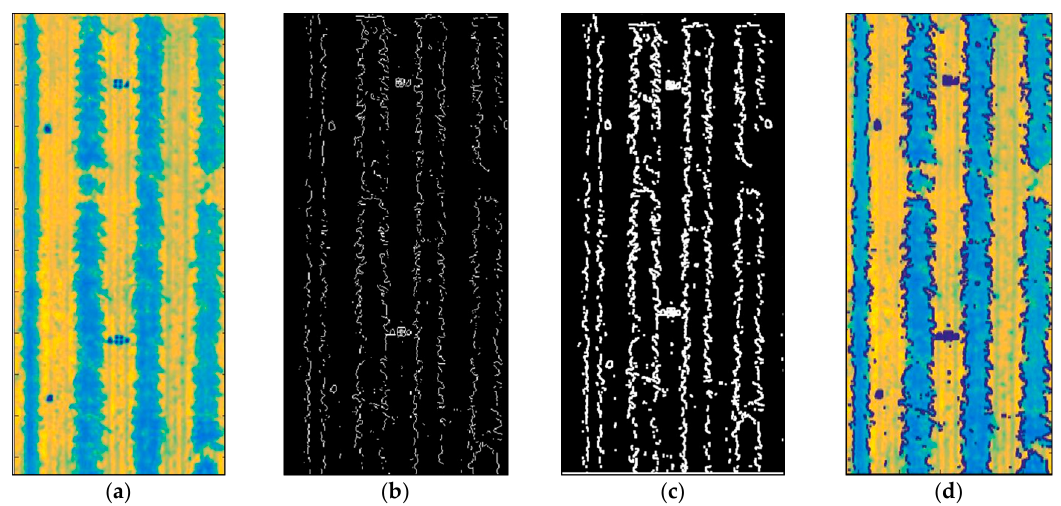
Figure 3 . ( a ) Example of the orthomosaic image; ( b ) extracted edges; ( c ) dilated edges; ( d ) eliminated edges in the orthomosaic image. Table 2 . Classified sub-regions within the studied field based on crop cultivar and tree training system. Sub-Region Crop